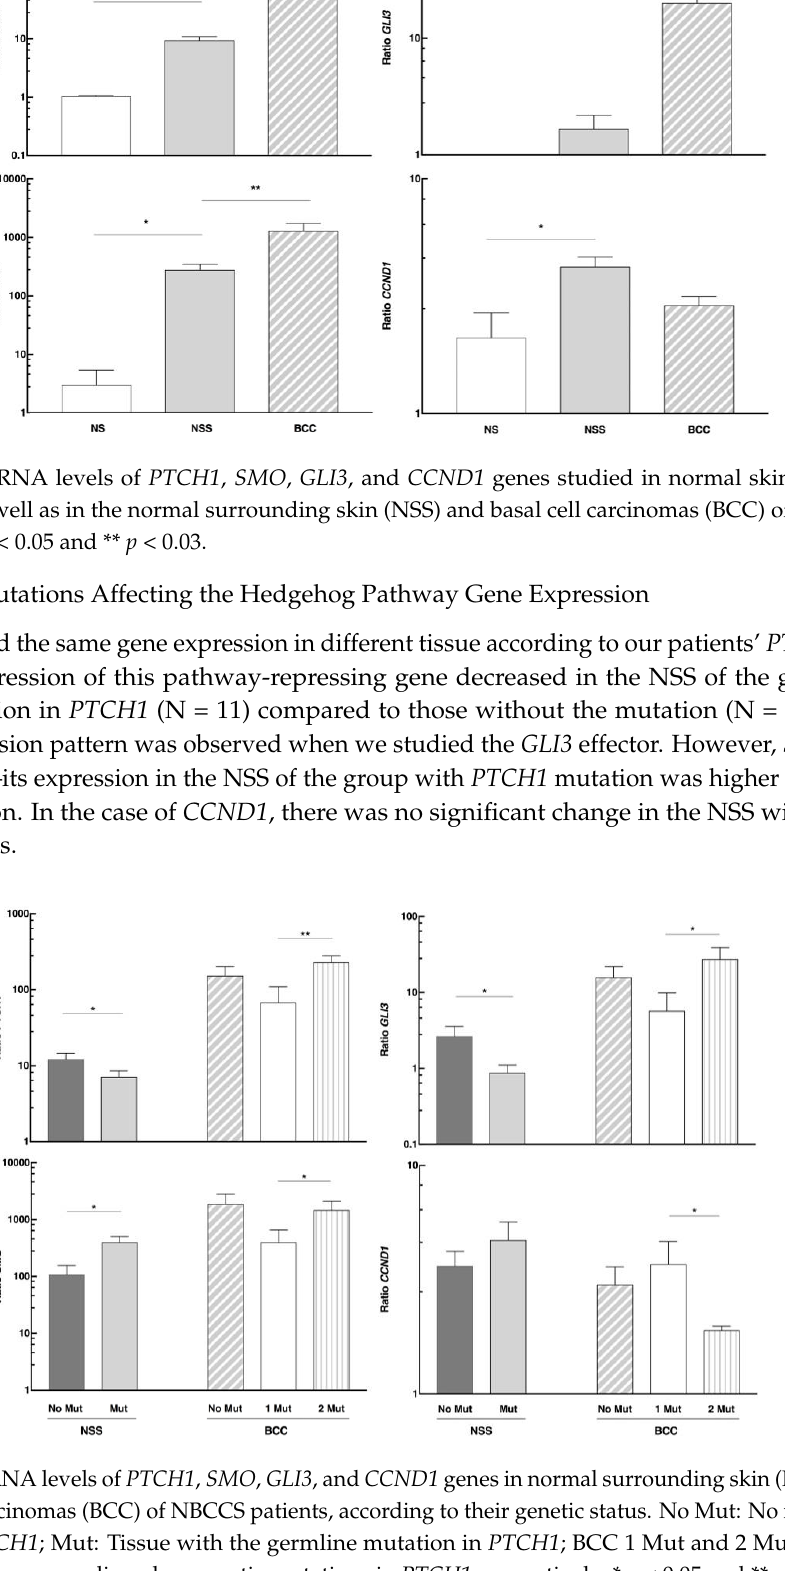
Cells 2019 , 8, x 7 of 12 Figure 2. Genealogy tree of families with nevoid basal cell carcinoma syndrome (NBCCS) and known germline mutation: ( A ) SG6 family, ( B ) SG7 family, ( C ) SG12 family, ( D ) SG13 family, ( E ) SG20 family, and ( F ) SG21 family. The black arrows indicate the studied proband. Symbols filled in black indicate affected members with clinical manifestations. Symbols with “?” indicate that no clinical diagnosis was made. Symbols filled in grey indicates the family member affected by Autosomal Dominant Polycystic Kidney Disease (ADPKD) whereas the stripped ones indicate the family members affected by NBCCS and ADPKD. M: Mutation found in PTCH1 ; No M: No mutation in PTCH1 . Patient SG7 and his family were examined, as this patient’s neurologic image did not show the corpus callosum (a criterion that is not particularly sought in these patients), along with a negative family history of BCC (one of the typical criteria for NBCCS). The discussion involved the HH pathway in the primary cilium, which participates in the embryonic commissural plate’s development pattern that originates from the corpus callosum [124]. Patient SG20, who inherited NBCCS from her paternal side without BCCs at the time of enrollment, presented an inheritance pattern of autosomal dominant polycystic kidney disease via the maternal line. Polycystic kidney disease is a ciliopathy, since the anomalous protein responsible is also located in the primary cilium, as are the HH pathway components [13]. 3.2. Hedgehog Pathway Gene Expression To investigate the effects of detected mutations on the Hedgehog pathway gene expression, we quantified the expression of genes PTCH1 , SMO , GLI3, and CCND1 in BCC (N = 20), NSS samples (N = 20) from NBCCS patients, and NS from healthy controls (N = 4). PTCH1 , SMO , and the GLI3 effector—whose expression is almost undetectable in NS—had an